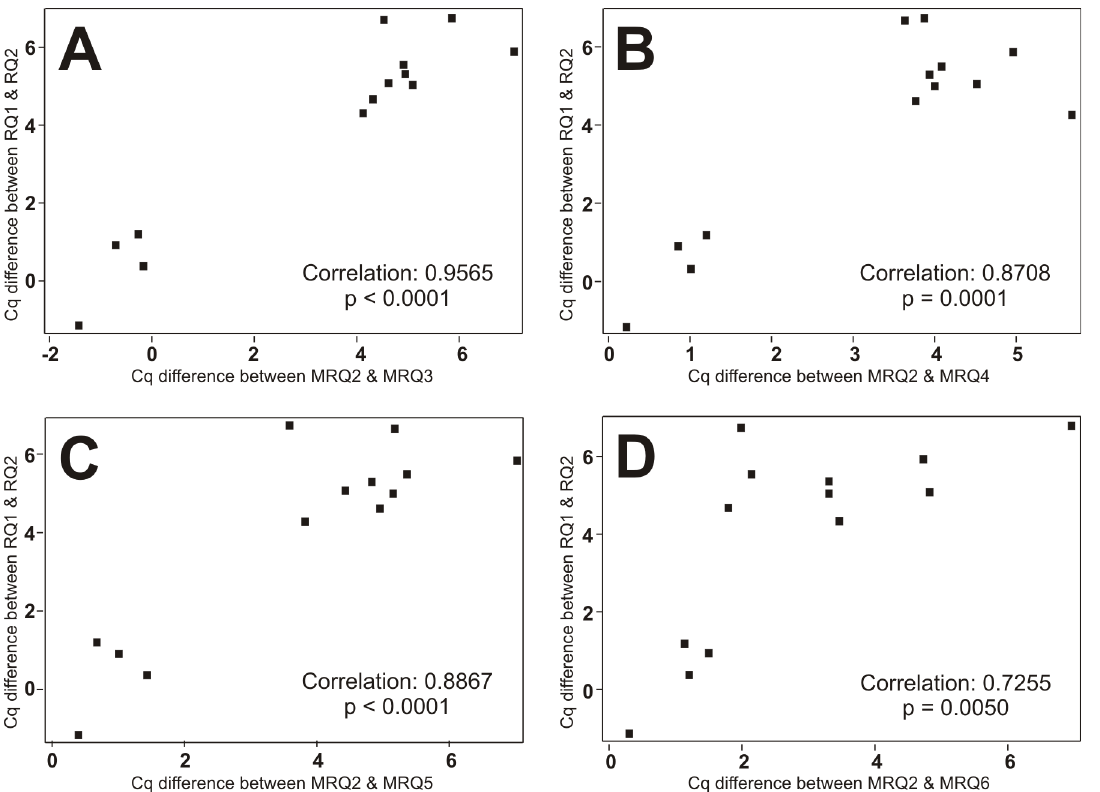
Fig 7. Scatter plotting of the correlation of differential Cq values between Bio-Rad ’ s RQ (BRQ) primers and MRQ primer pairs. Pearson correlation coefficient analysis for RQ1/RQ2 and MRQs on the 13 cDNA samples was carried out by using SAS v9.3 software. The differential Cq values between BRQ1/2 and MRQ2/3 (A) , MRQ2/4 (B) , MRQ2/5 (C) , MRQ2/6 (D) , as well as MRQ2/1 (data not shown), were all statistically positively correlated. The correlation between BRQ1/2 and MRQ2/3 is the largest, while the BRQ1/2 and MQR2/1 is the least (data not